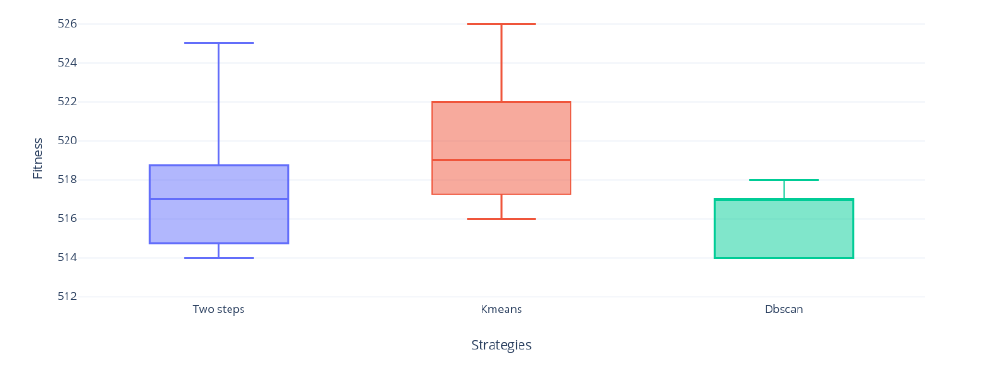
Figure 8. Instance 4.10 distribution.